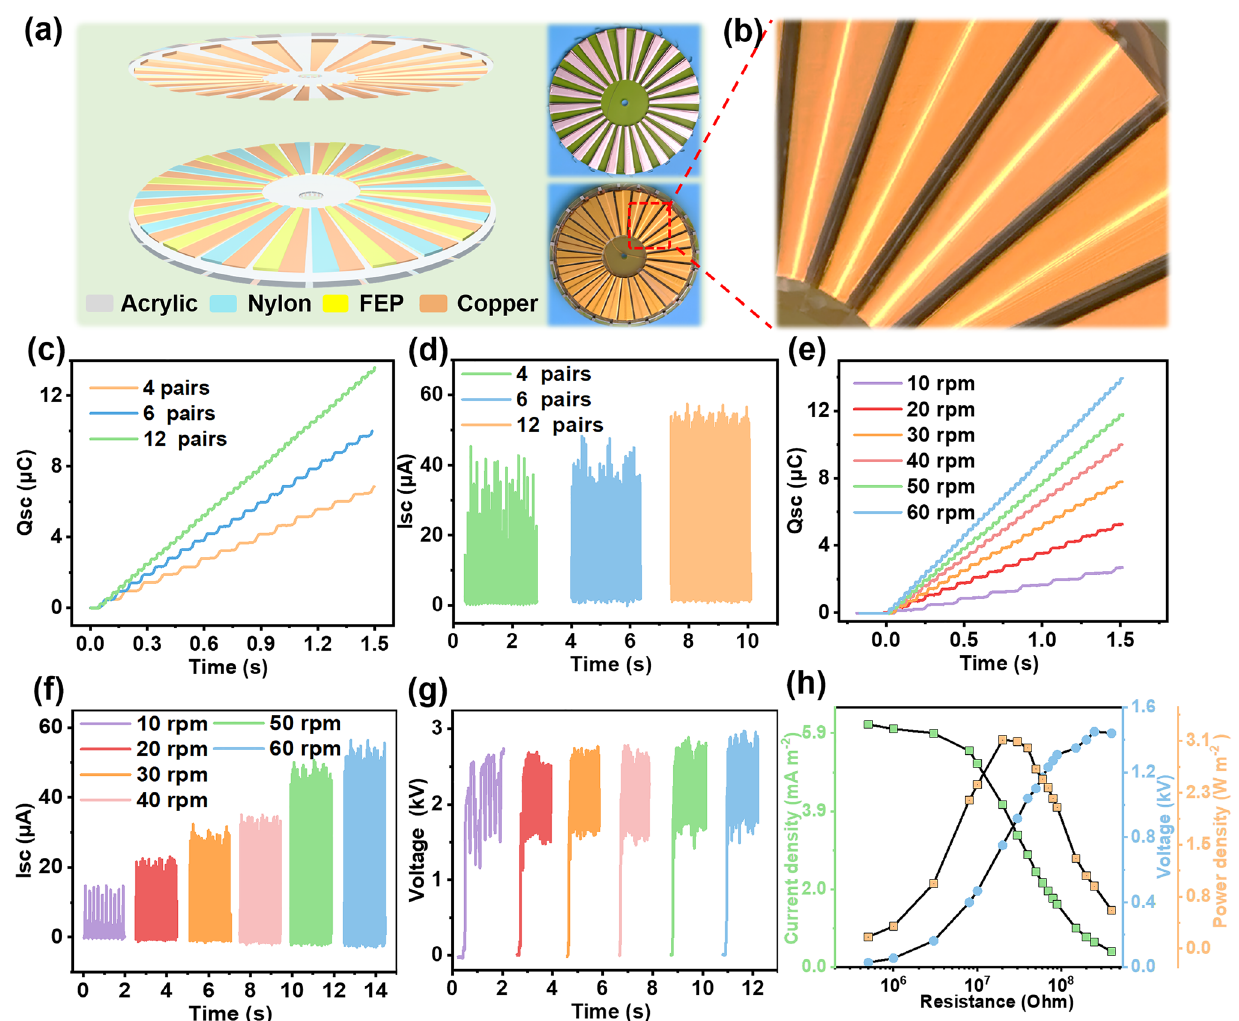
Fig. 3 The structure and performance of the R-PC-TENG. a 3D structural schematic of the R-PC-TENG device, and photographs of rotator and stator parts. b Partial enlarged detail of stator. c, d Transfer charge ( Q sc ) and short-circuit current ( I sc ) of R-PC-TENG with different pair of electrodes. e–g Transferred charge ( Q sc ), short-circuit current ( I sc ), and open-circuit voltage of the R-PC-TENG at different rotational speeds. h Evaluation of matching impendence and output power of the R-PC-TENG at rotational speed of 60